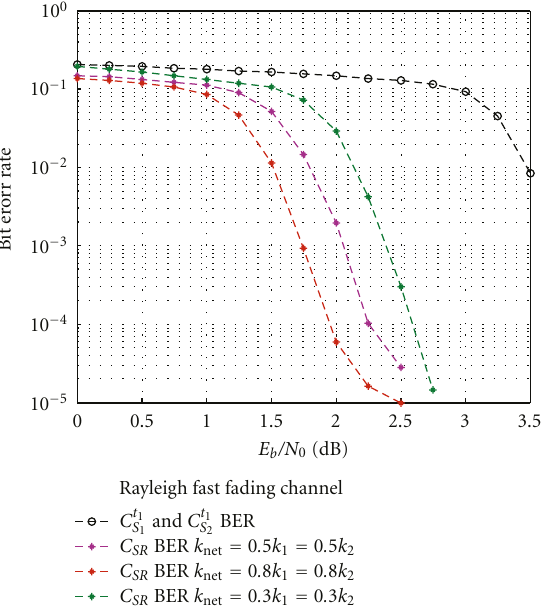
Figure 18: The BER performance under the Rayleigh Fast Fading channel with di ff erent lengths of extra check